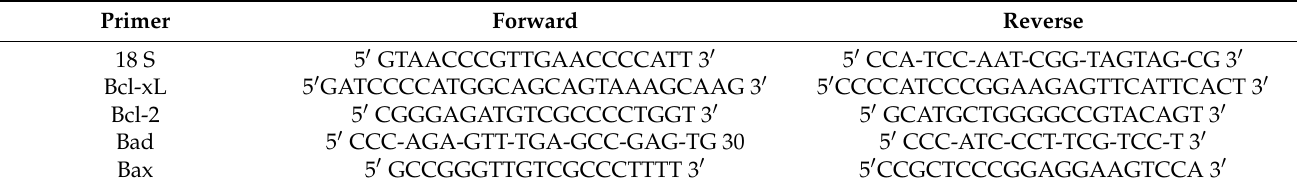
Table 1. Presentation of oligonucleotides corresponding to the primers